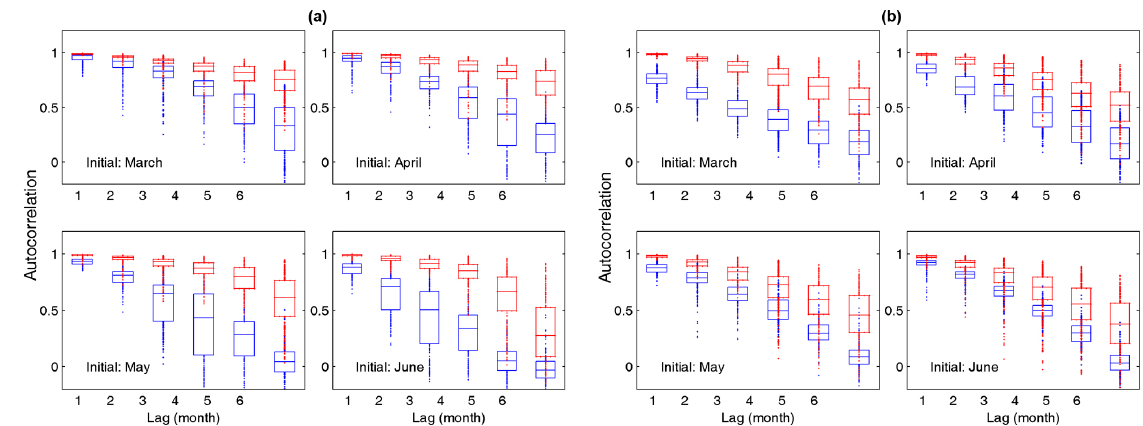
Figure 1. Box plots of autocorrelation coefficients (up to 6months) of accumulated 6-month precipitation (blue) and soil moisture (red) from MERRA-Land for different initial month for (a) California and (b) Texas. The box plots show the median (center), 25th (lower) and 75th (upper) percentile edges.